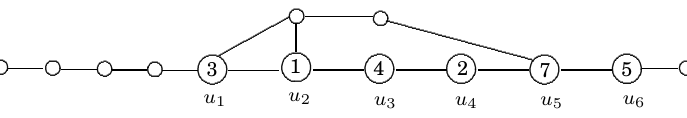
Figure 8: The graph G in the proof of Theorem 3.1.